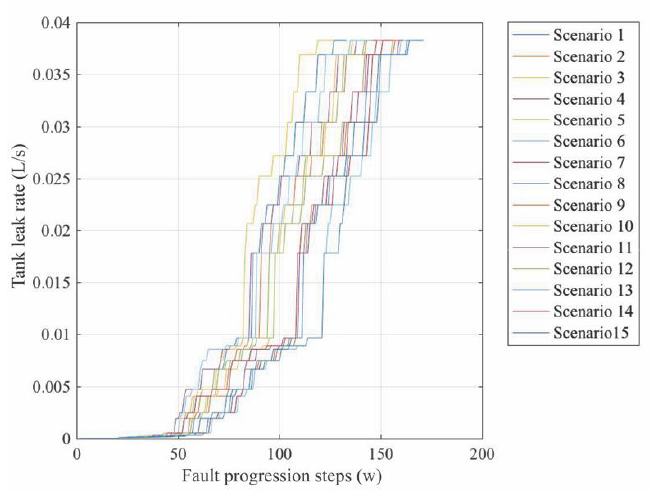
Figure 14. Fault progression processes.